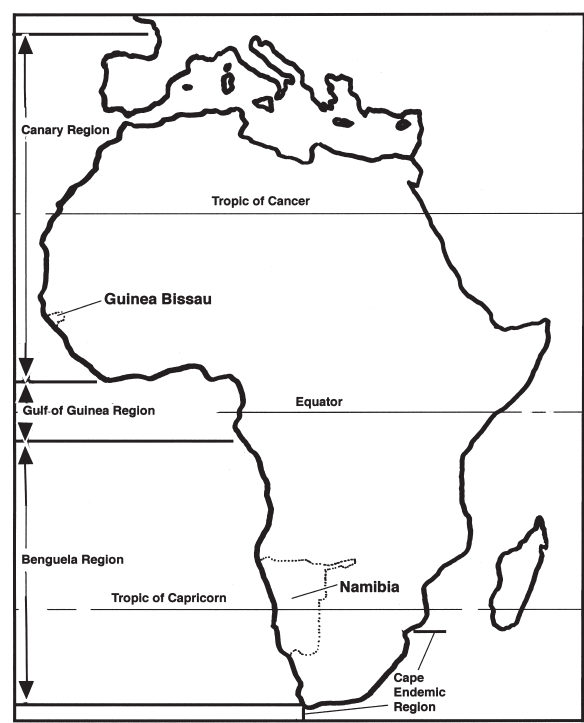
F IG . 6. – Map of Africa showing various regions of western